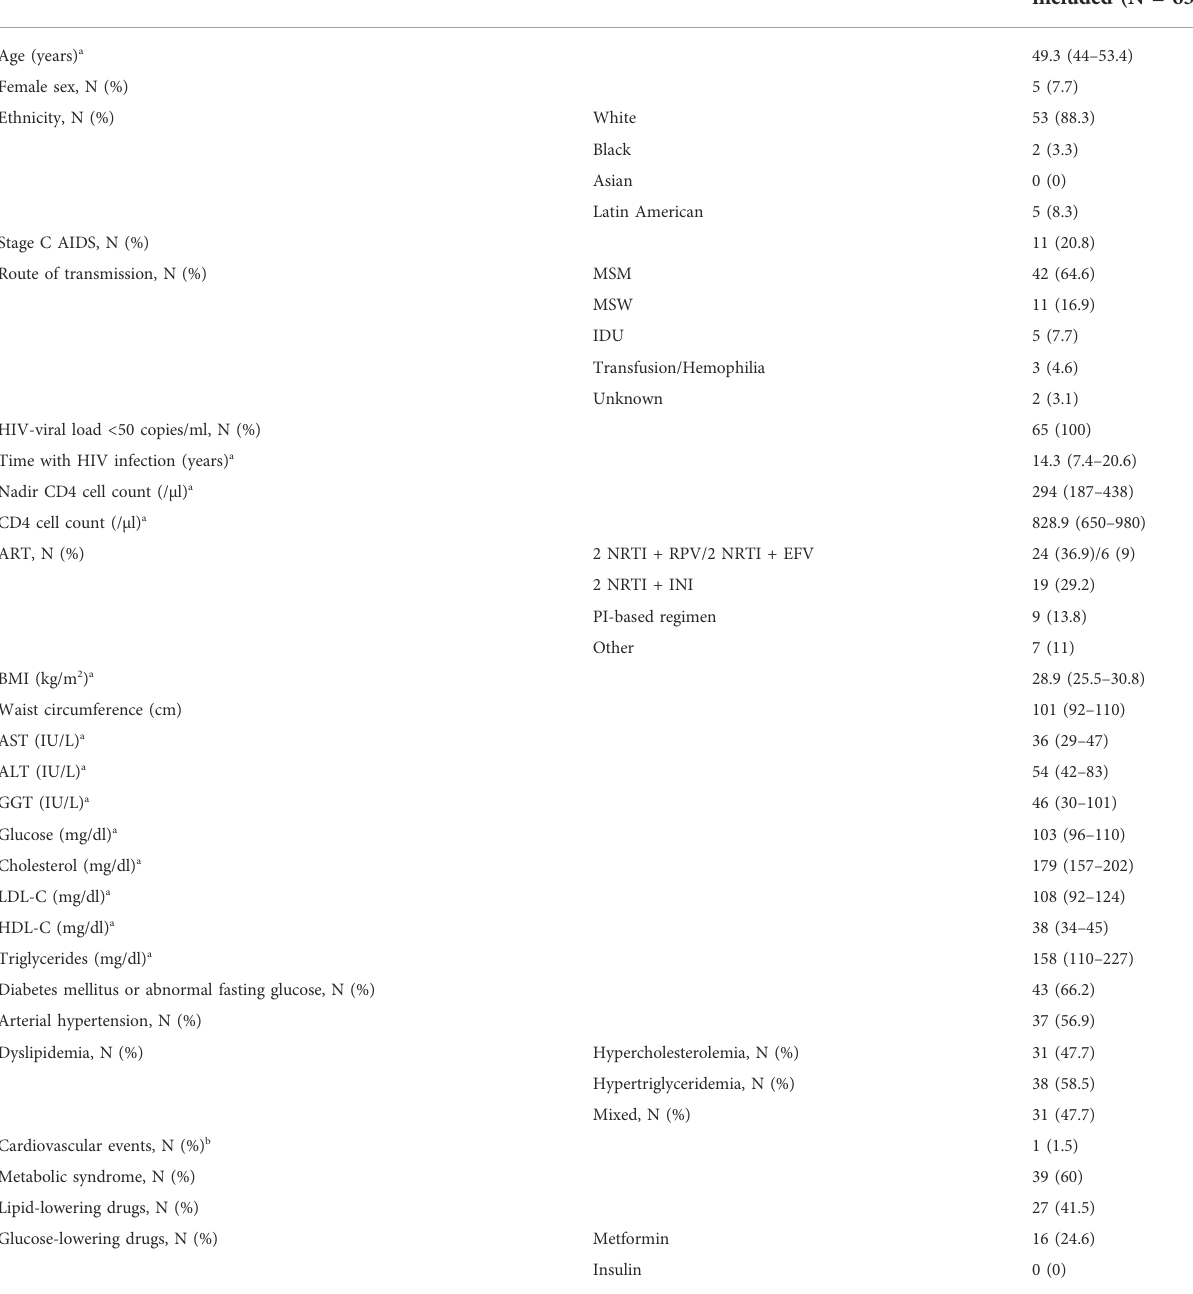
TABLE 1 Characteristics of the study